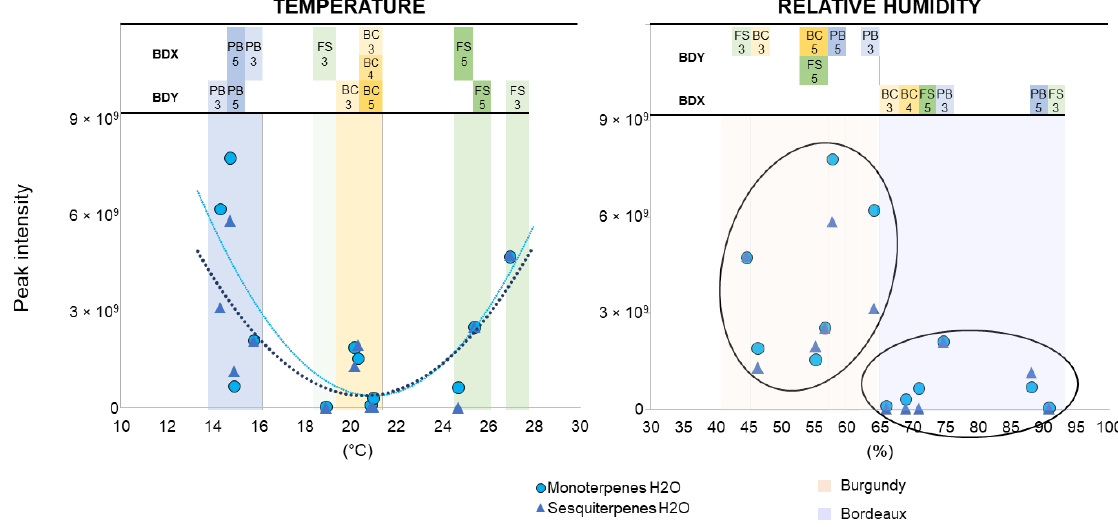
Figure 6. Impact of climate parameters on terpene detection on H 2 O-treated grapevines. Grapevine terpenes were analysed three- and/or five-days post treatment with H 2 O (control). Values for terpenes correspond to peak area values from Burgundy (cv. Chardonnay) and Bordeaux (cv. Cabernet franc) vineyards in 2019. Collection days and phenological stages of grapevines (pre-blossom: PB; fruit-set: FS, bunch-closure: BC) are indicated above the climate parameters for each vineyard (Burgundy: BDY; Bordeaux: BDX). The shapes of the tendency curves were chosen to best fit the point values.